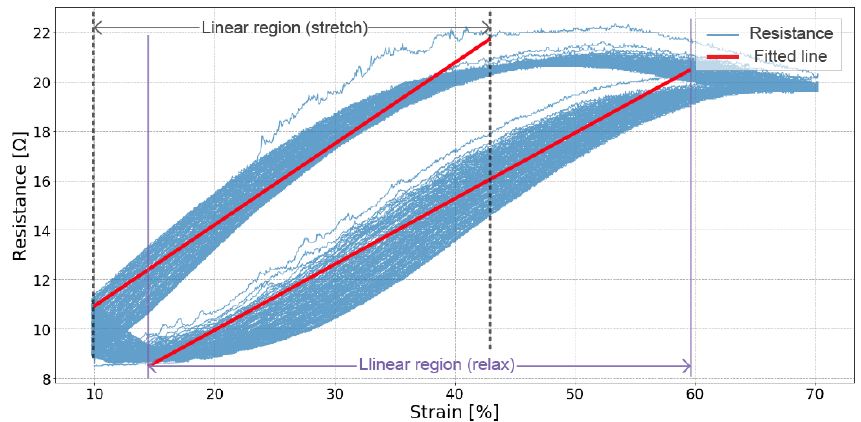
Figure 3. An example of linearity fitting of the dynamic test for Sample 04. The linear region of stretch and relaxation are identified and then fit with a line.